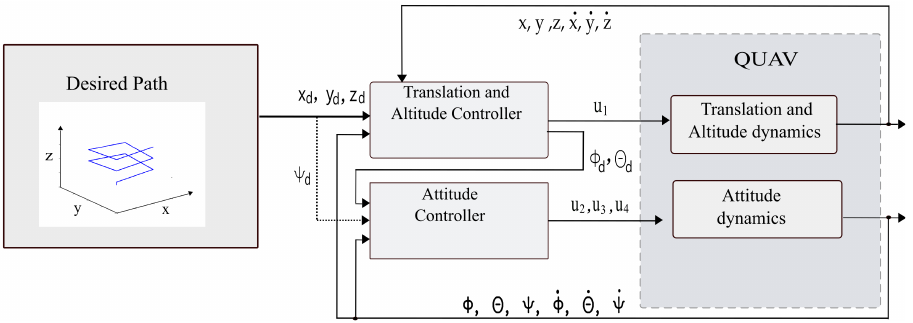
Figure 3. Proposed control structure to trajectory